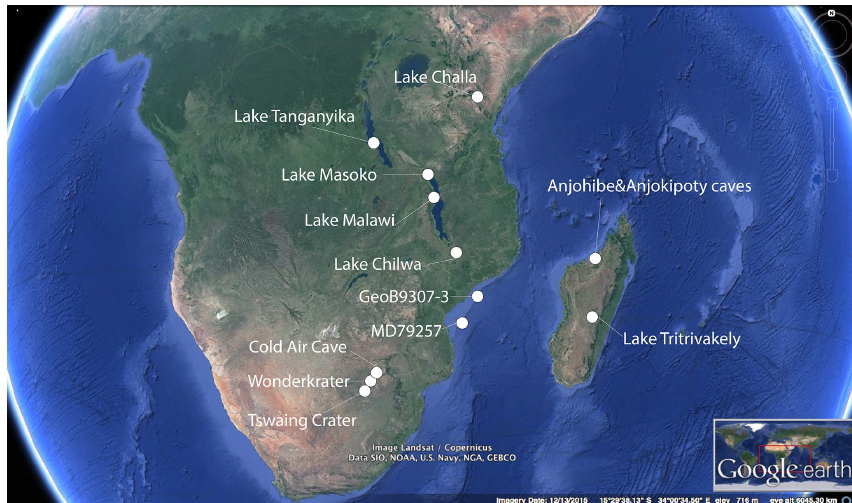
Figure 8. Regional comparison. Google Earth image showing the location of sites reported in Table S3 and in Fig. 9. Most site records are from lake sediments, except for GeoB9307-3 (onshore off delta sediments), MD79257 (alkenone from marine sediment core), and Cold Air, Anjohibe, and Anjokipoty caves (stalagmites δ 18